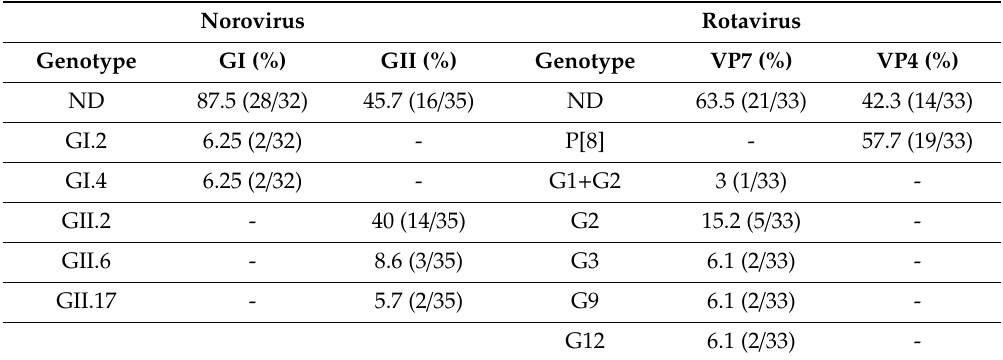
Table 3. Prevalence of norovirus GI, norovirus GII, and rotavirus in sewage samples from Valencia. ND is indicated when the genotype was not